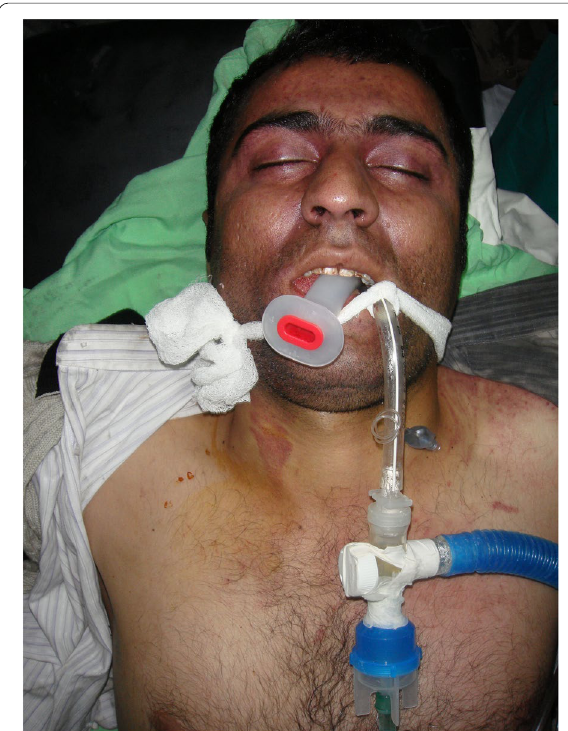
Fig. 7 Bluish to violet cyanotic discoloration of face and neck of sedated and intubated 2nd patient in the series